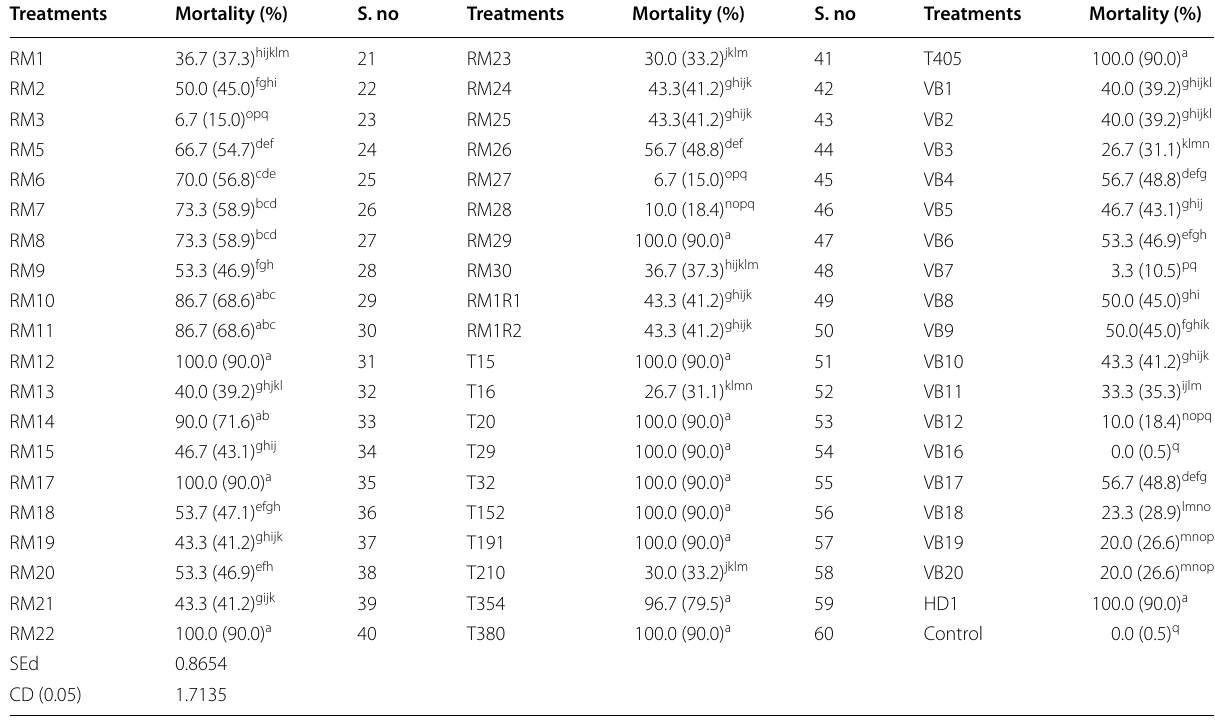
Figures in parentheses are arcsine transformed values of percentages Values followed by same letters in a column are not significantly different (0.05) by DMRT